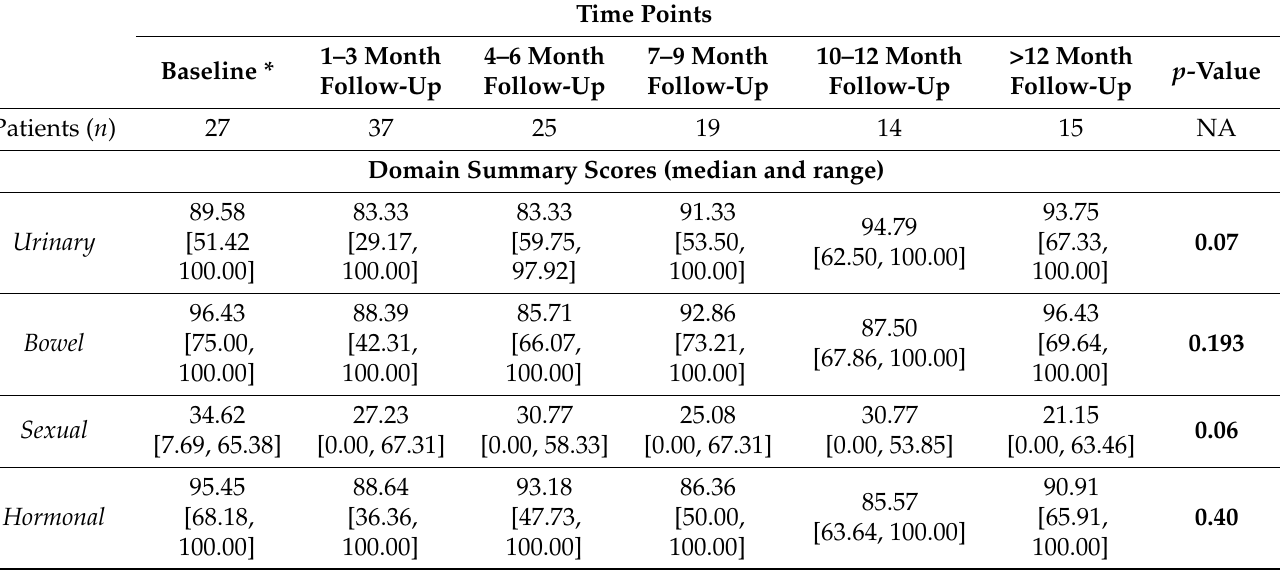
Table 4. Patient-reported outcome measurement based on the Expanded Prostate Cancer Index Composite